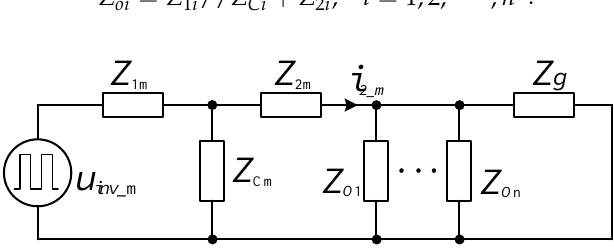
Figure 2. Implified model of LCL filter network for G o_m .